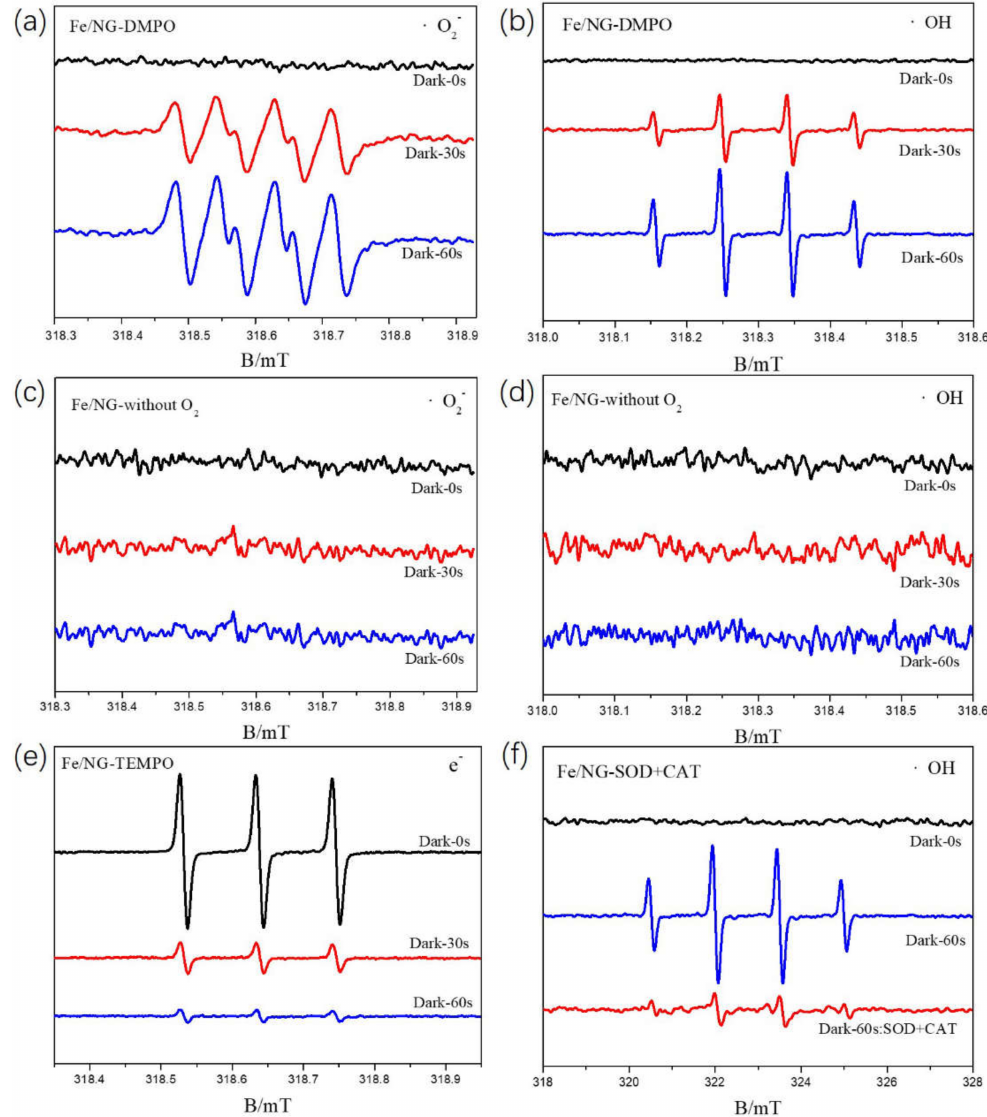
Figure 10. ESR spectra of radical adducts in Fe/NG ( a , b , e ); ESR spectra of radical adducts in Fe/NG without O 2 ( c , d ); Inhibition effect of 8 mg mL − 1 SOD and 8 mg mL − 1 CAT on the Fe/NG solution ( f